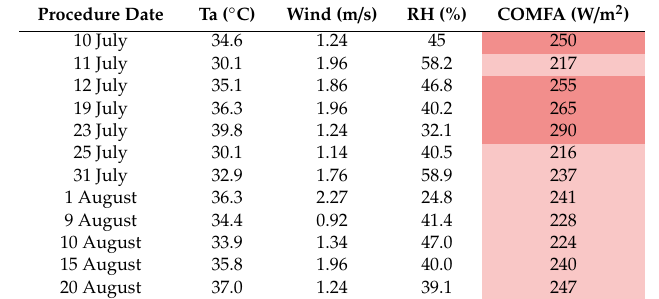
Table 5. Recorded meteorological data collected. Column labeled Ta is the air temperature ( ◦ C); Column Wind is the recorded wind speed (m / s); Column RH is the relative humidity %; Column COMFA represents the calculated energy budget (W / m 2 ) for a person during the procedure. All conditions in the study ranged from 201 W / m 2 to 339 W / m 2 , a level that Harlan, Brazel, Prashad, Stefanov, and Larsen [25] identified as being in danger of heat stress.